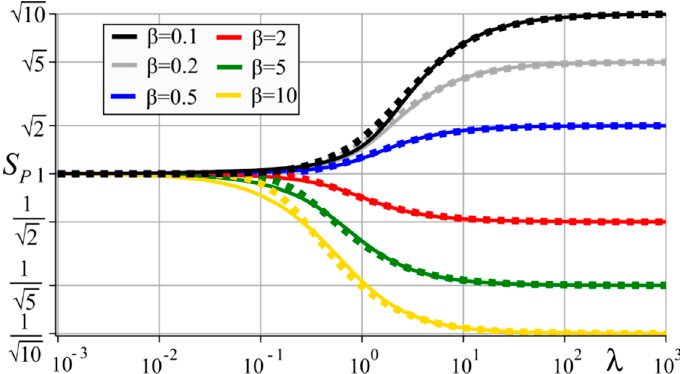
Figure 6. Relative indentation stiffness S P for the homogeneous coatings calculated with N >>1 (solid line) and N = 1 (dashed line).